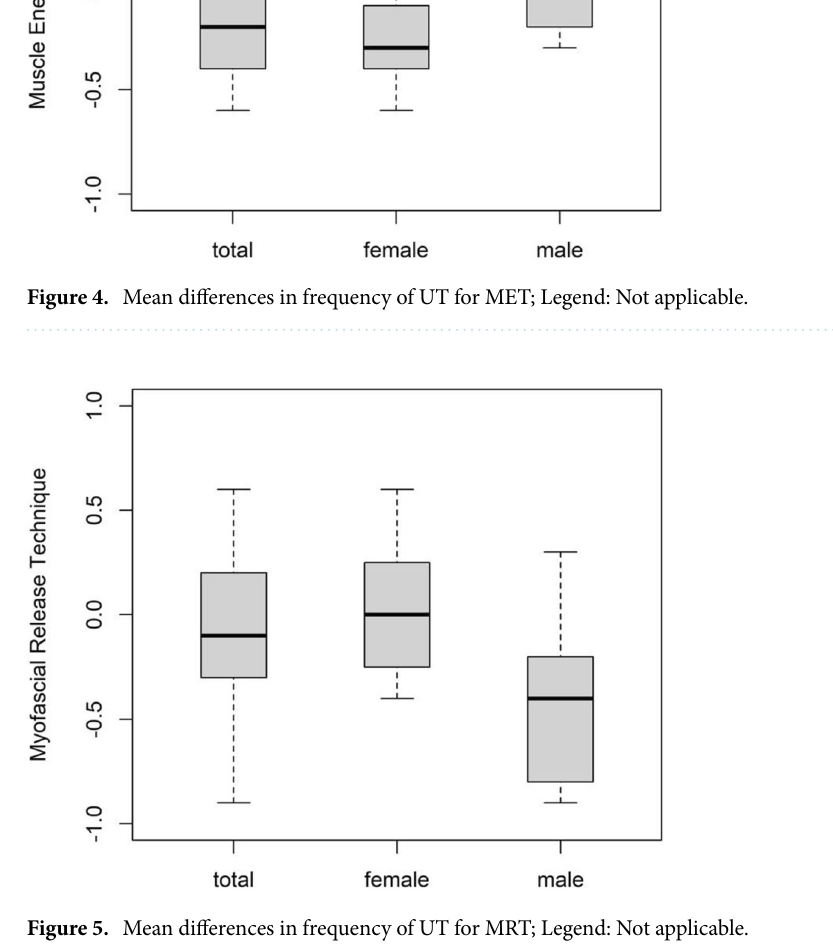
Figure 5. Mean differences in frequency of UT for MRT; Legend: Not